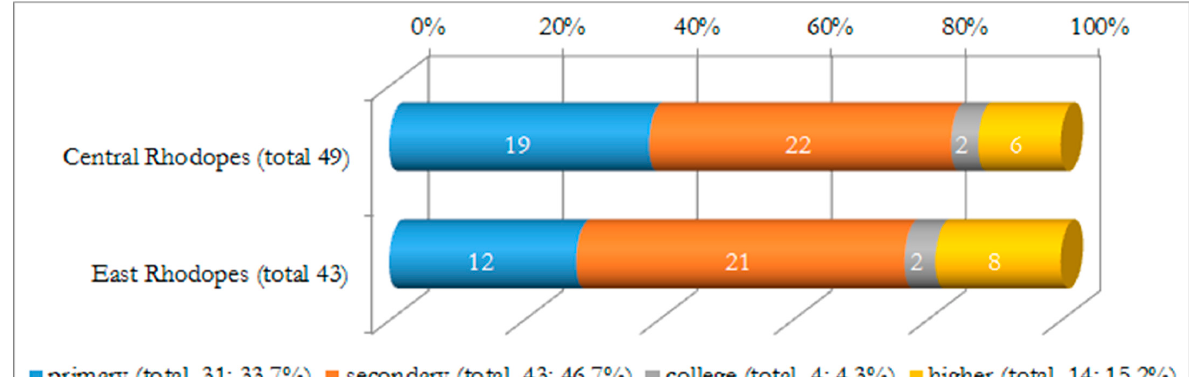
Figure 3. Demographic characteristics of informants by region and education.